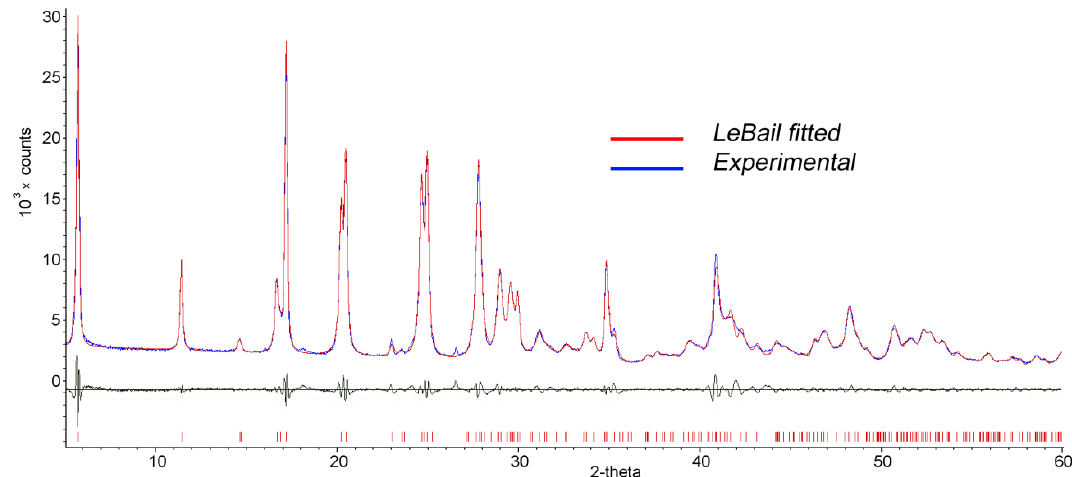
Figure 4. LeBail fitted (red line) and experimental (blue line) diffraction patterns of the In 1.2 Ga 0.8 S 3 ·0.5(p-AP) intercalation compound.